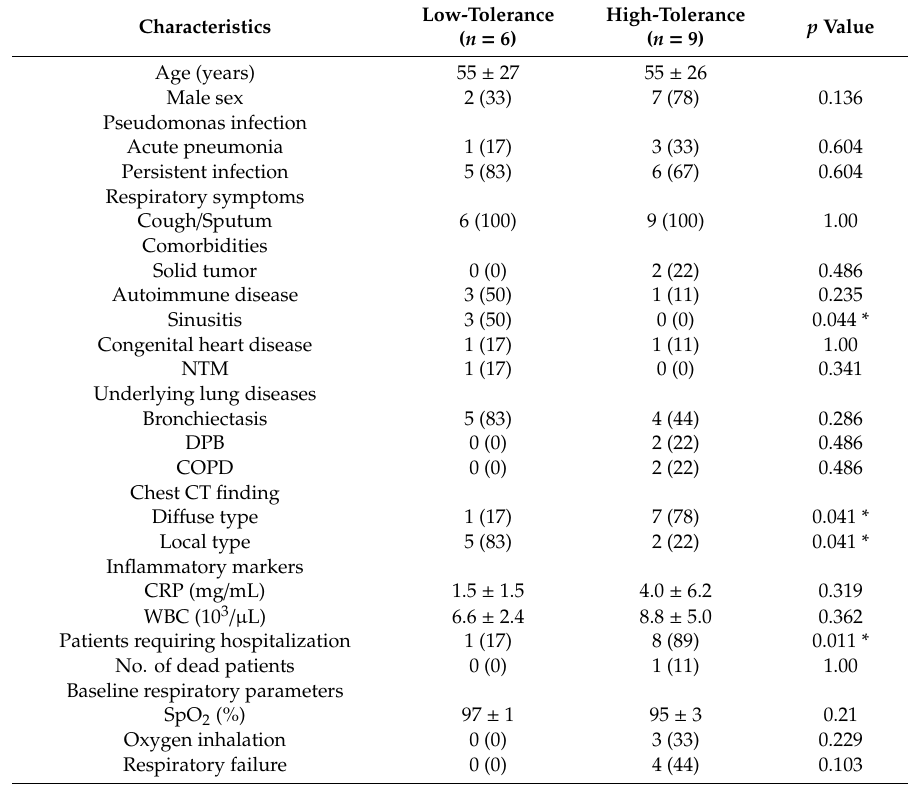
Table 1. Clinical features of low- and high-tolerance